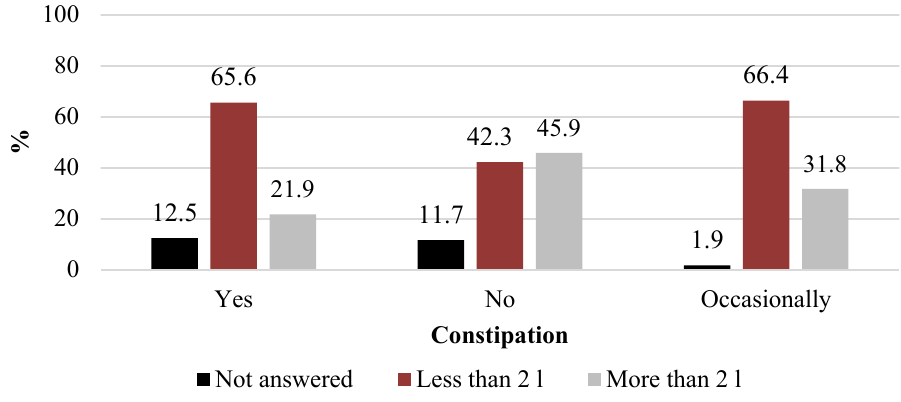
Fig. 5. Liquids consumption by the respondents (p=0.001),